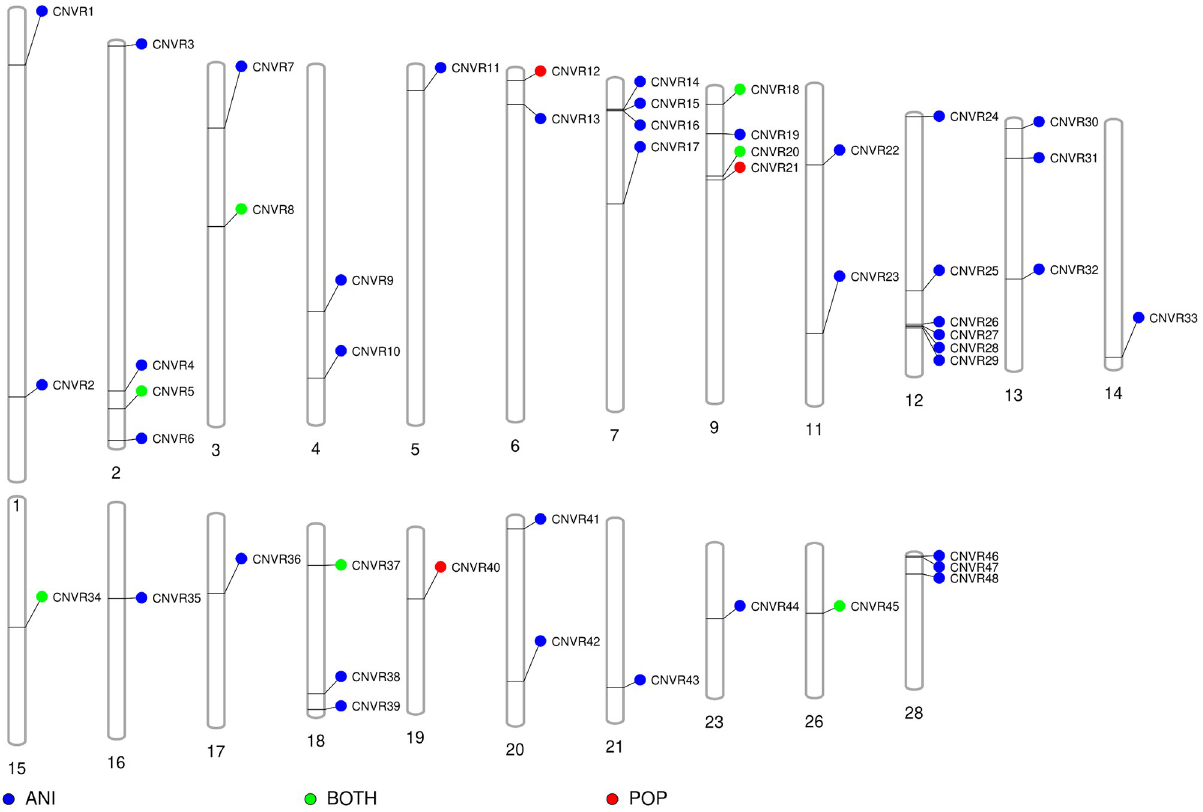
Fig 3. Distribution of unique high confidence copy number variation regions (CNVR) in the bovine genome. The CNVR_ANI (ANI), CNVR_POP (POP), and CNVR sets present in both sets (BOTH) are represented. Only autosomal chromosomes with CNVR are represented.